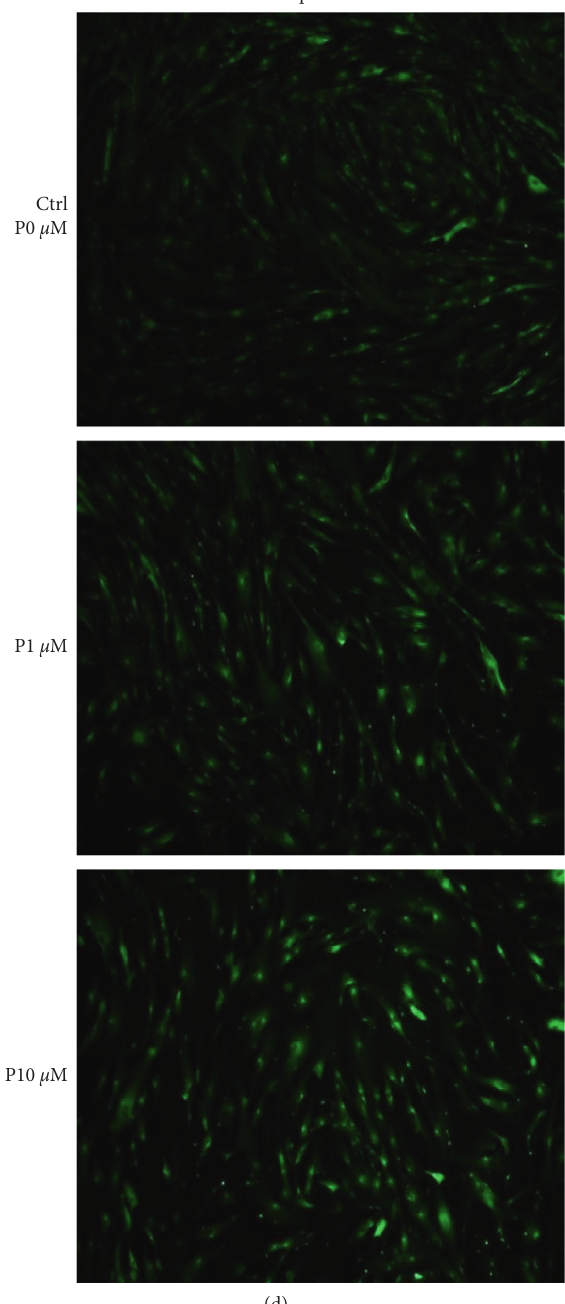
Figure 4: Specific effect of pentosidine on fibroblast monolayers. Determination of IL8 (a), CXCL2 (b), and MMP12 (c) gene expression in fibroblast monolayers (2D culture) from young or old donors after stimulation by pentosidine (young (T) or old (T) during 48 h). mRNA levels were quantified in fibroblasts using qPCR. Each point represents the mean value of normalized mRNA quantity ( n � 3). qPCR was performed in duplicate on three different samples. Data are expressed in arbitrary units (AU ± SD � arbitrary units ± standard deviation). Tropoelastin immunostaining (d) was observed in fibroblasts monolayers after pentosidine stimulation at 0, 1, and 10 μ M. Note that pentosidine stimulates tropoelastin expression by fibroblasts. Statistics: analysis of variance (ANOVA) adjusted post hoc Tukey–Kramer tests for pairwise comparisons ( ∗ p < 0.05; ∗∗∗ p <